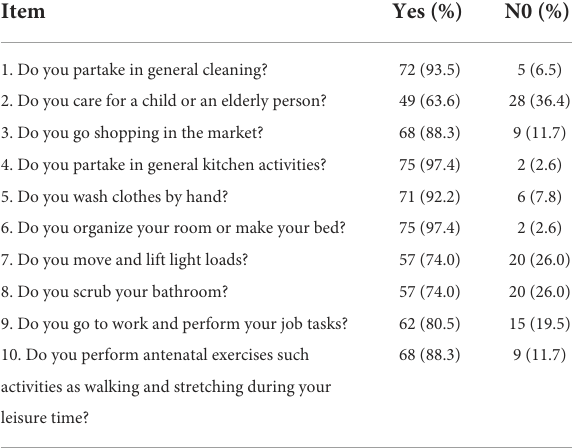
TABLE 7 Participants’ responses to questions on the type of PA ( n = 77).